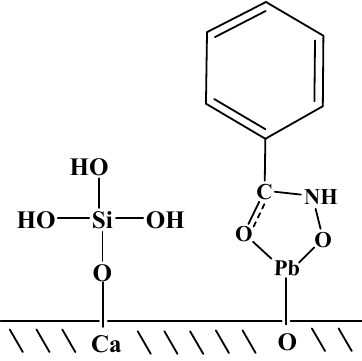
Figure 10. Adsorption diagram for silicic acid and a Pb- benzohydroxamic acid (BHA) complex on the scheelite surface.